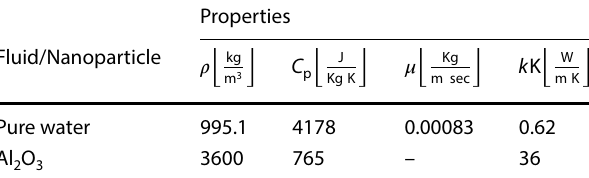
Table 1 Base fluid and nanoparticle properties adopted from Ho et al. [32]